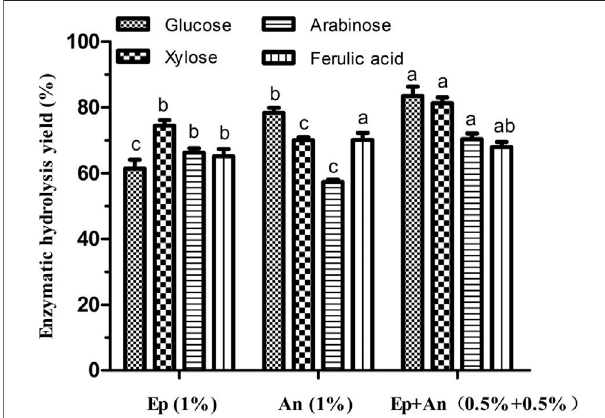
FIGURE 2 | Effects of individual or blended enzyme on the enzymatic hydrolysis of wheat bran autohydrolysis residue. Ep, crude enzyme from E. parvum ; An, crude enzyme from A. niger. Enzymatic hydrolysis yield of the sameproductbetweendifferenttreatmentswereconductedforoneway analysis of variance (ANOVA) and multiple comparisons, where different lowercase letters indicate signi fi cant difference at p < 0.05 probability level.